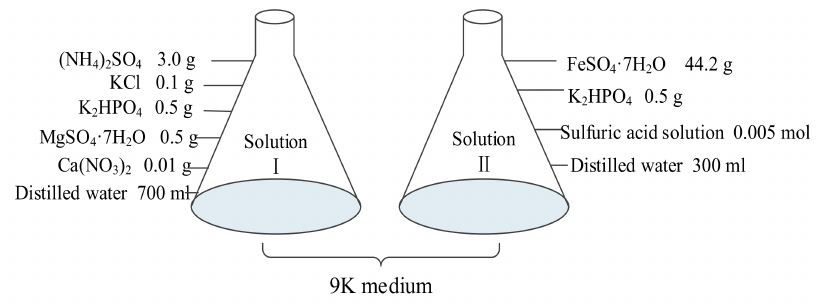
Figure 1. Composition of the 9K